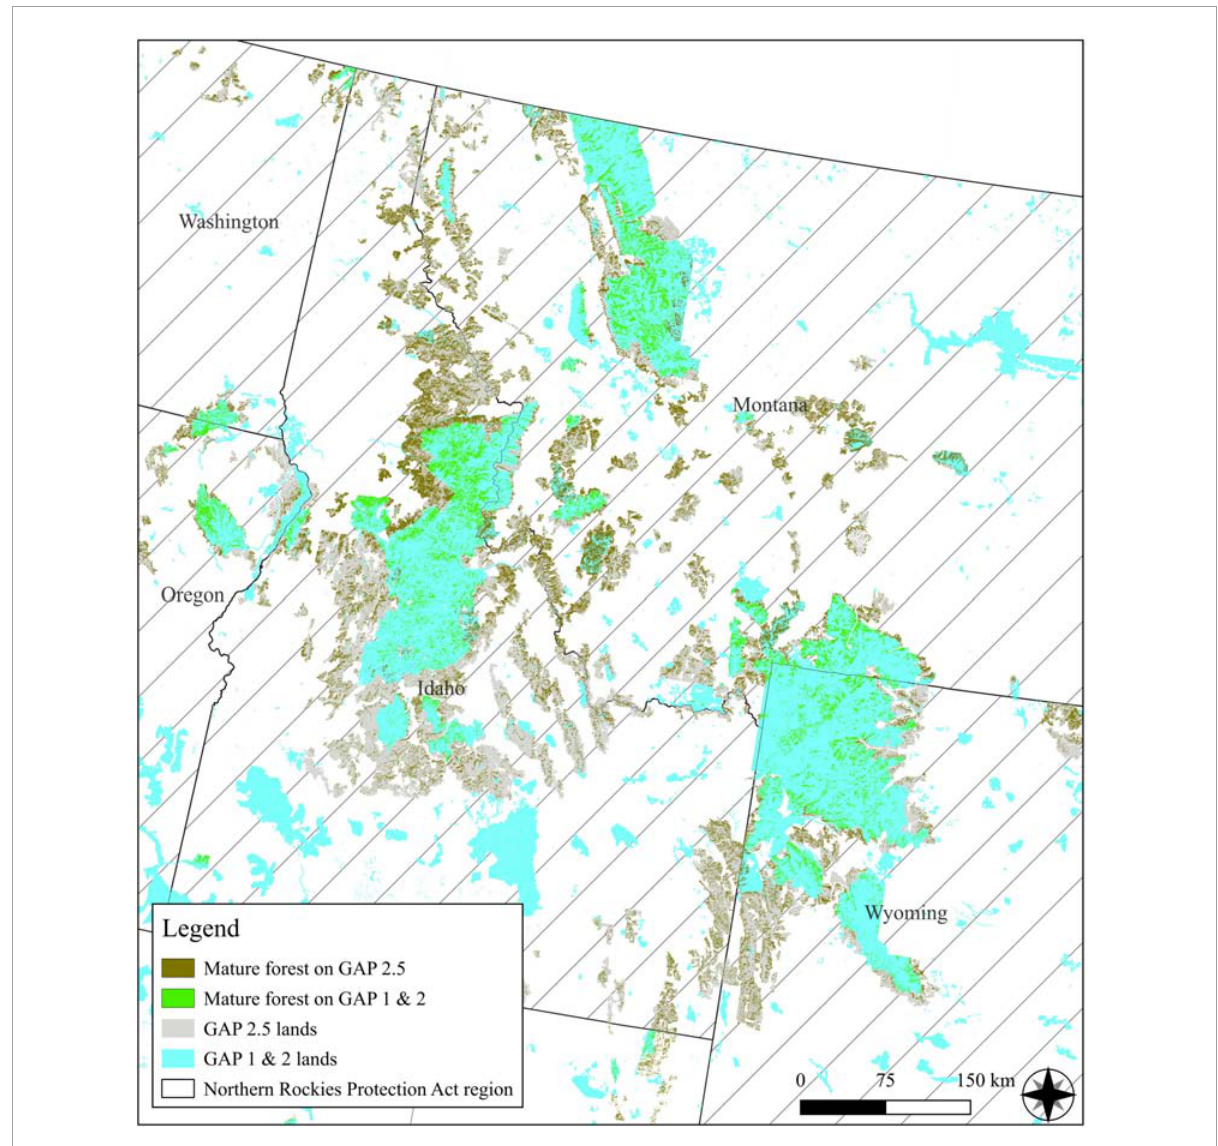
FIGURE5 Distribution of mature and old-growth forests within the proposed five state protection area (OR, WA, ID, MT, and WY) including the Bader (2000) and Northern Rockies Ecosystem Protection Act (2021) by GAP classifications. GAP2.5 refers to Inventoried Roadless Areas (IRAs) that are not fully